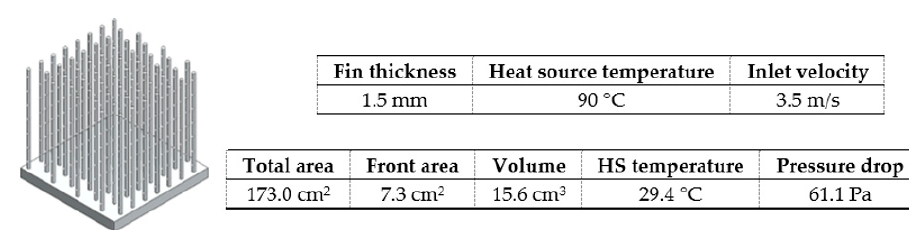
Figure 15. Pins heat sinks with frontal (H2) and side (H3) holes and radial pins heat sink with frontal holes (H4).